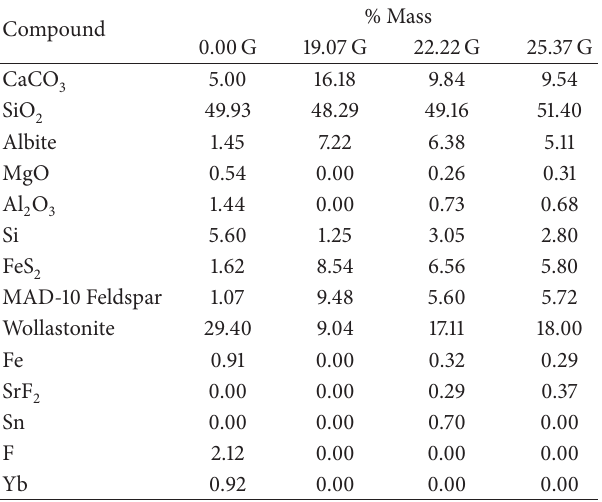
Table 2: Elemental composition of cement paste samples under different magnetostatic induction